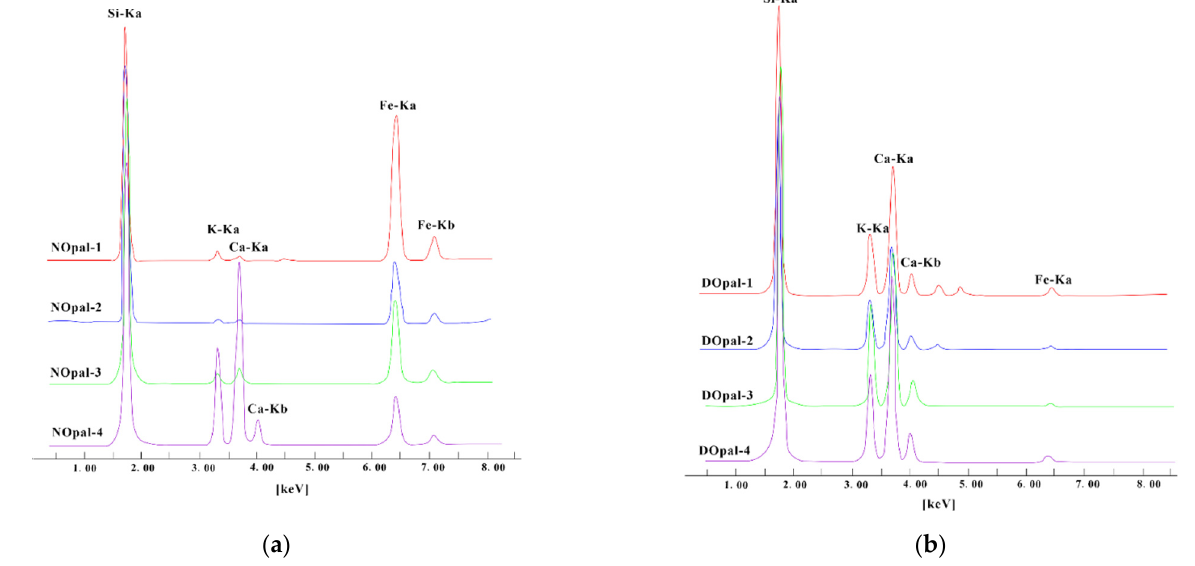
Figure 11. EDXRF spectrum of samples: ( a ) natural opals; ( b ) dyed opals. Table 5. Count ratio of Fe/Si in samples.